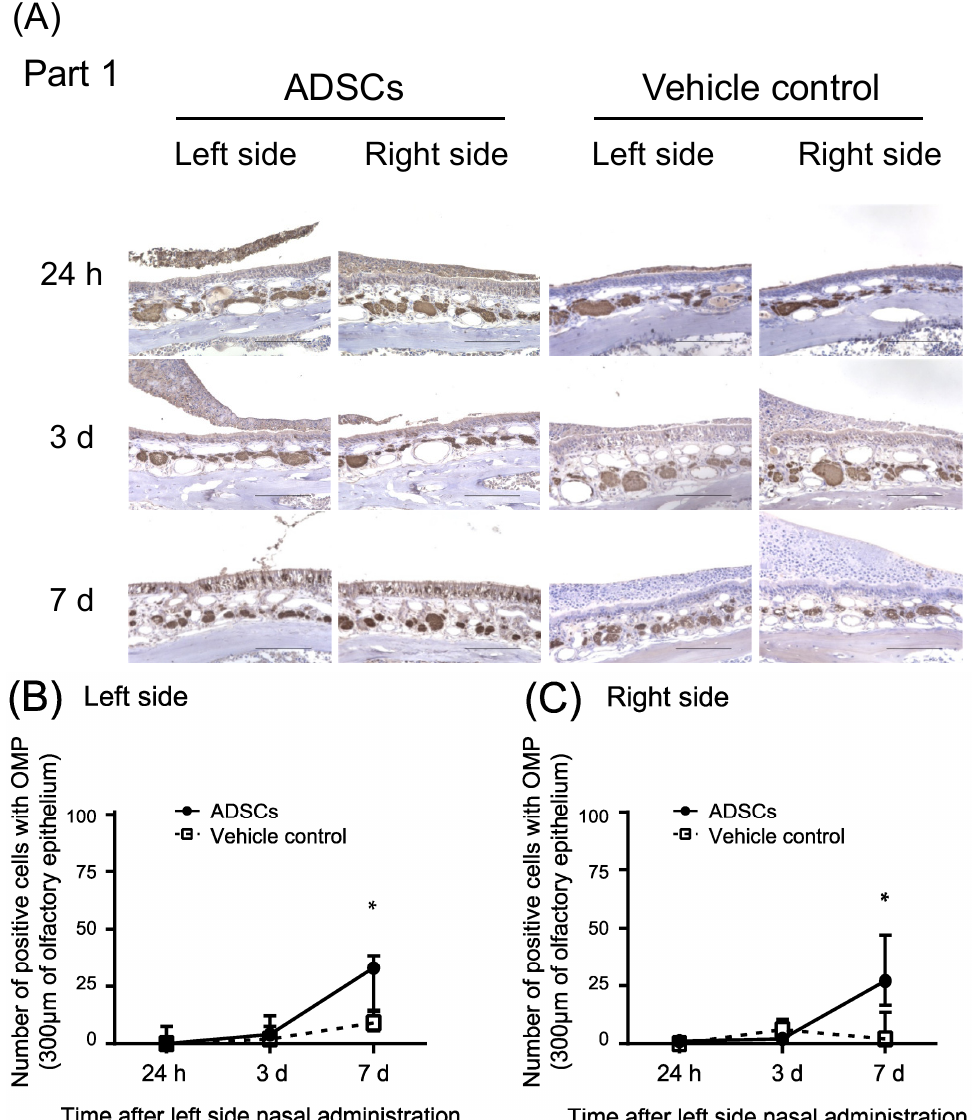
Figure 3. Immunohistochemical analysis of olfactory marker protein in the upper-middle region of the nasal septum (Part 1) of mice 24 h, 3 d, and 7 d after nasal administration of ADSCs. ( A ) Representative images of immunohistochemical staining of olfactory marker protein (OMP). ( B , C ) Number of positive cells with OMP in the upper-middle region of the nasal septum of mice. ( B ) Left side. ( C ) Right side. Images are representative of five mice for each treatment group. Bars = 100 µ m. Statistical significance was determined by the Mann–Whitney test. * p <